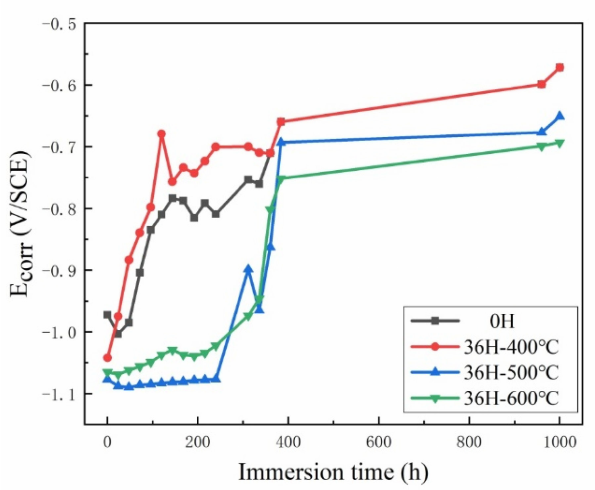
Figure 11. Open − circuit potential diagrams of the as-prepared WB zinc − based coating (0H) and the coatings baked at temperatures 400 ◦ C, 500 ◦ C and 600 ◦ C.